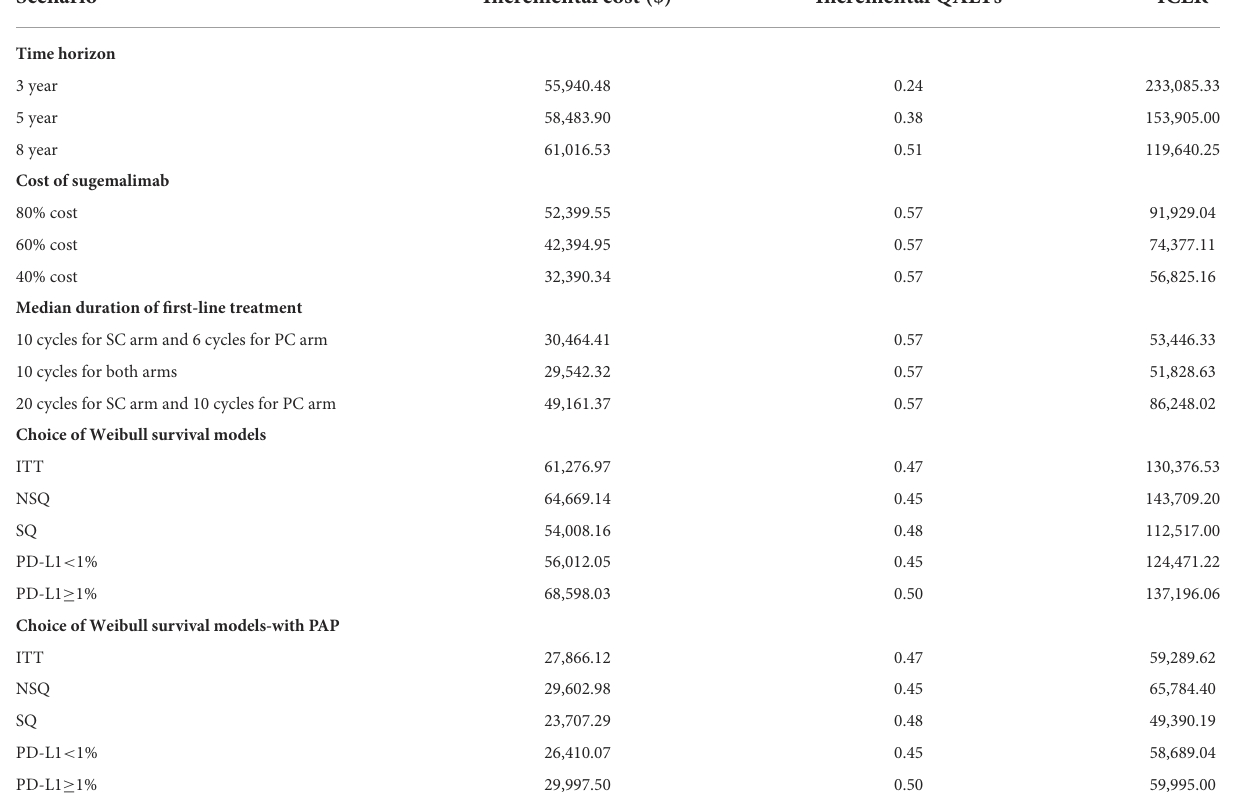
TABLE 4 Results of scenario